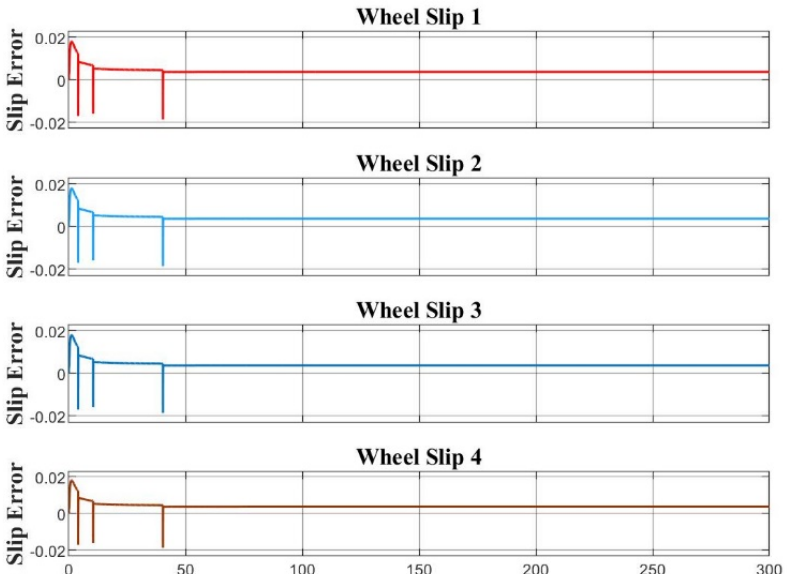
Figure 10. Tire Slip error without fault.